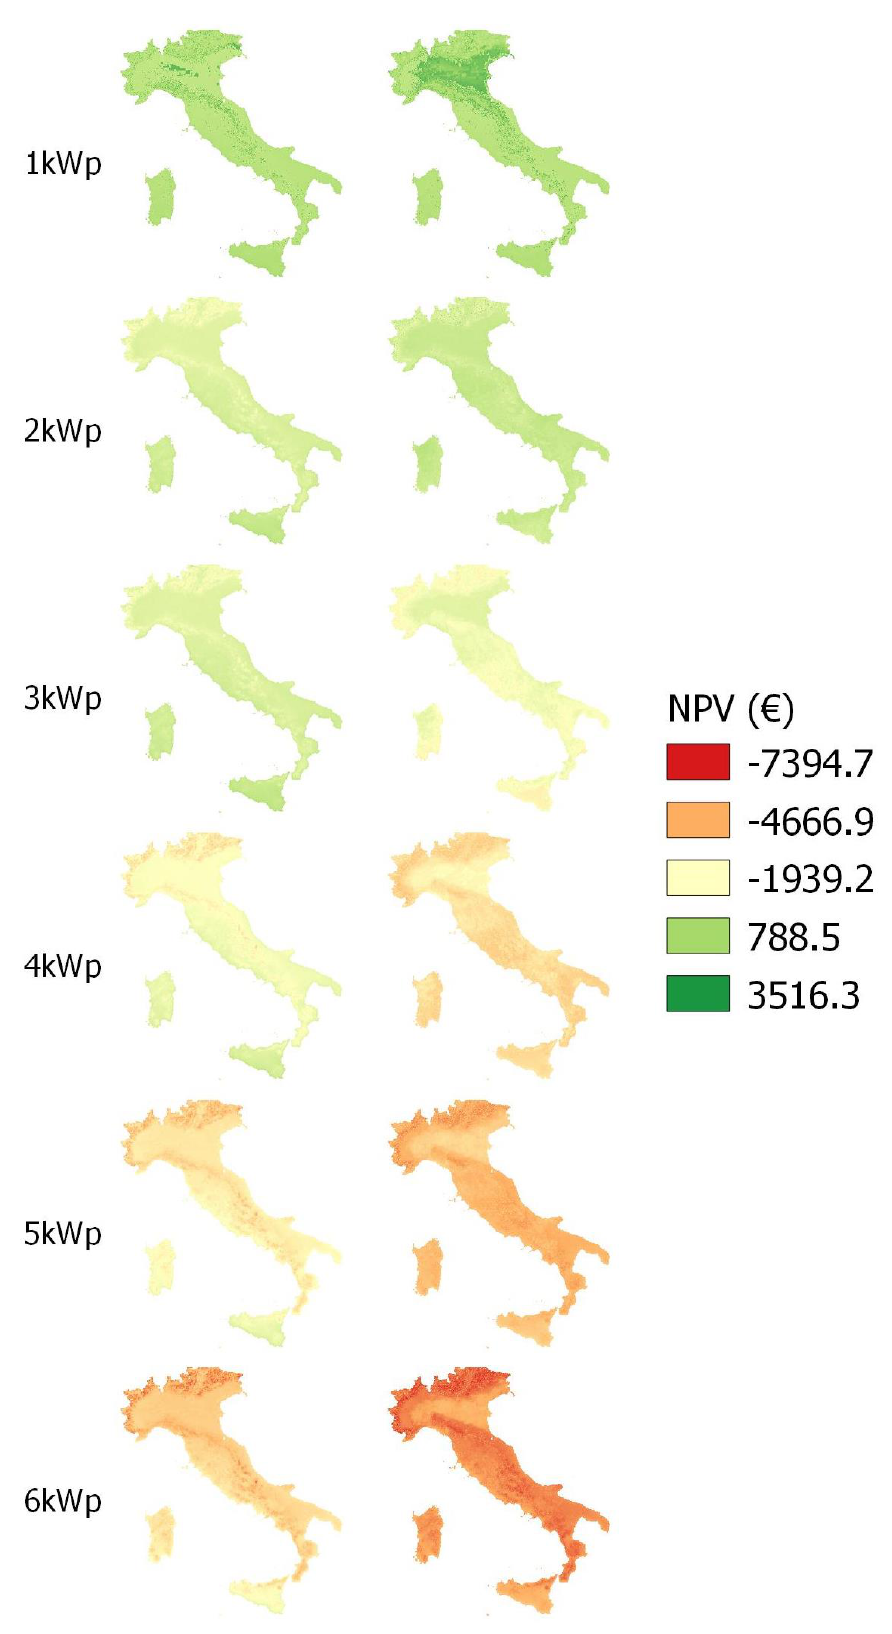
Figure A5. NPV for E L = 2700 kWh, left side without battery and right side with